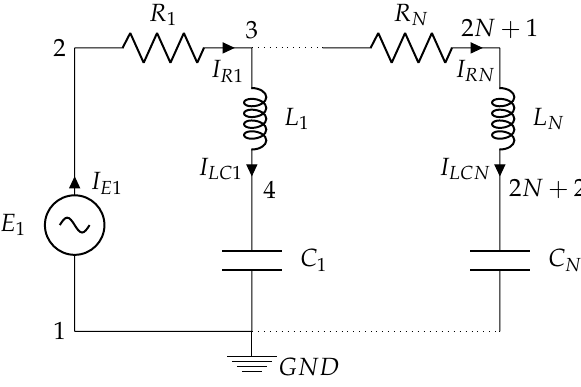
Figure 2. Diagram of a scalable RLC circuit with constant